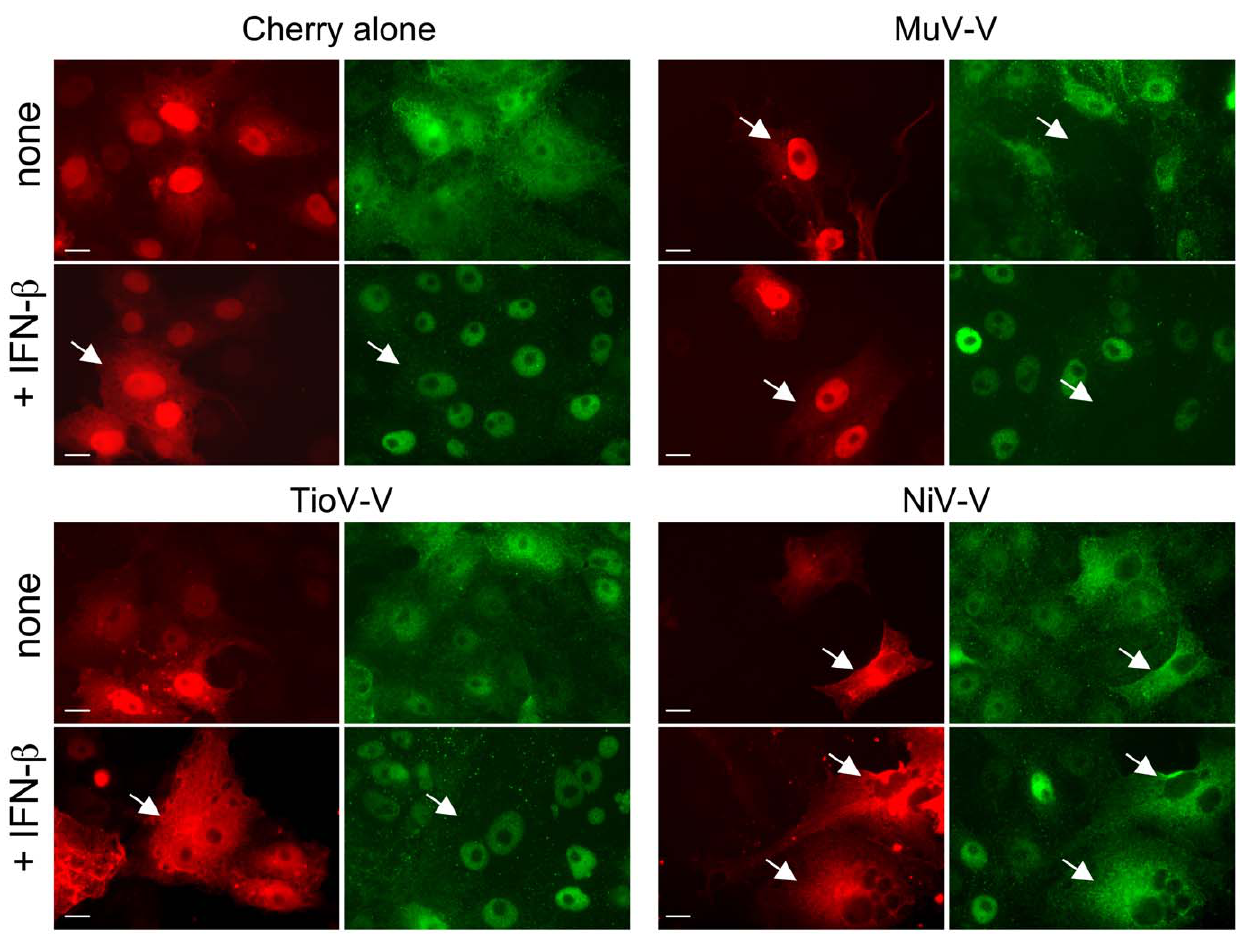
Figure 8. TioV-V does not inhibit STAT1 nuclear translocation induced by IFN- b . Vero cells were transfected with 100 ng of each plasmid encoding Cherry alone or fused to TioV-V, MuV-V or NiV-V. After 48 h of culture, cells were stimulated with IFN- b for 30 min, and STAT1 was labeled by immunostaining to determine its subcellular localization pattern. Green color corresponds to STAT1 whereas red corresponds to Cherry alone or Cherry-tagged viral proteins. Data show representative fields for each culture condition, and white arrows indicate cells expressing Cherry or Cherry- tagged viral proteins. Scale bar =10 m m.